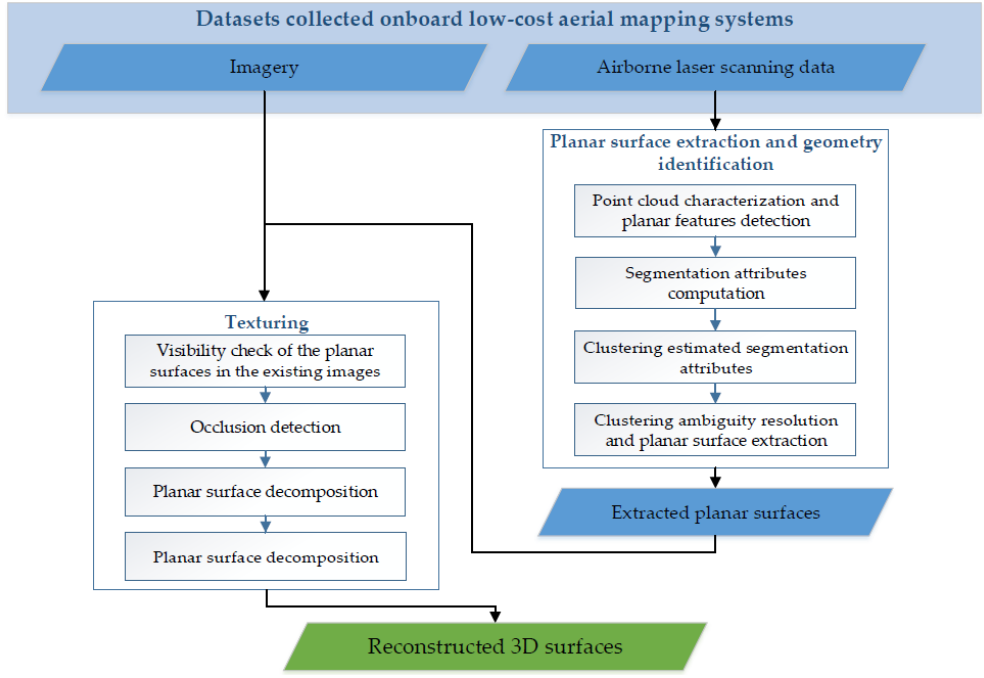
Figure 1. The outline of the proposed 3D scene reconstruction approach.